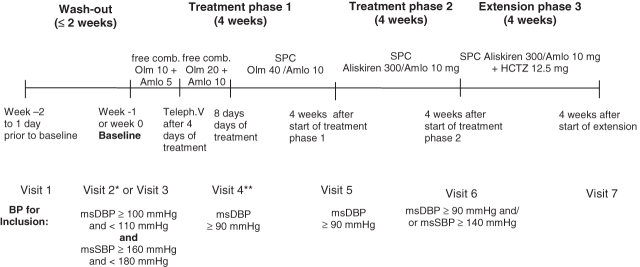
Study design. *Visit 2 was performed only in patients with previous antihypertensive therapy. **Patients with an office mean sitting DBP<90 mmHg at an unscheduled visit after visit 4 or at visit 5 were discontinued from the study. Dotted box highlights study phase from which data were analyzed for this paper.